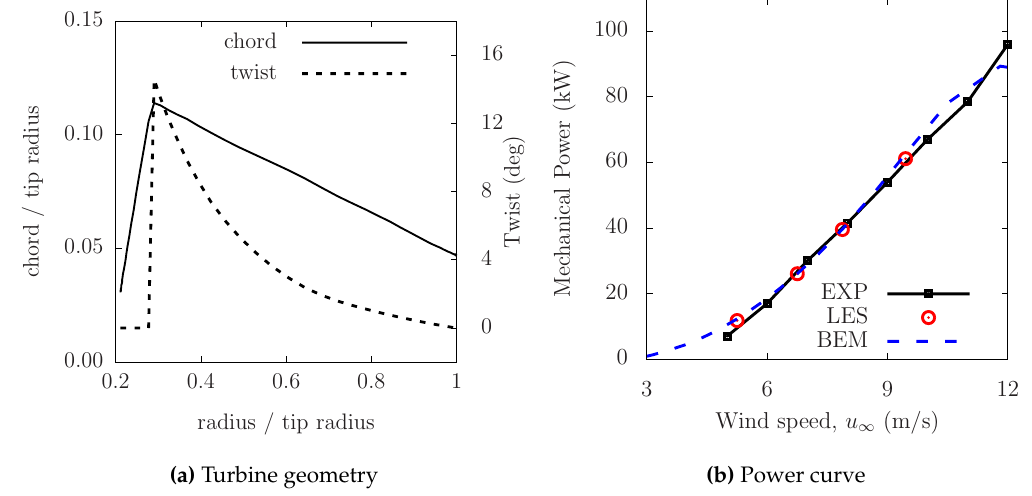
Figure 2. Verification of LES predicted results for the Tellus (Risø) turbine. ( a ) Non-dimensional rotor blade chord and twist variation; and ( b ) power curve variation with wind speed compared against data and blade element momentum